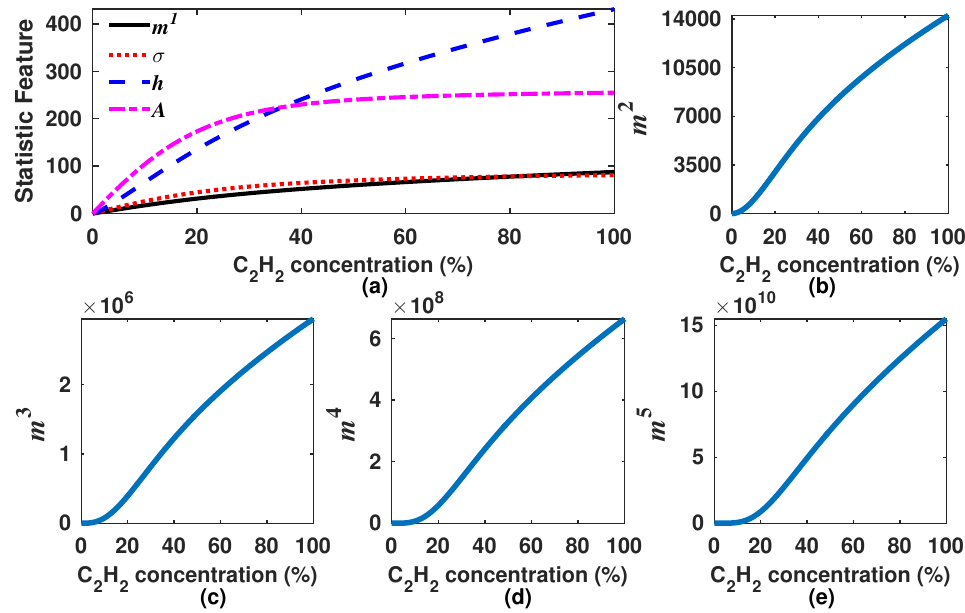
Figure 5. Statistics features of the sensor output waveforms as a function of C 2 H 2 . ( a ) the mean ( m 1 ), the standard deviation ( σ ), the entropy ( h ) and the peak amplitude ( A ) of D M are shown; ( b–e ) some k -th moments over the origin ( m k ) of D M are